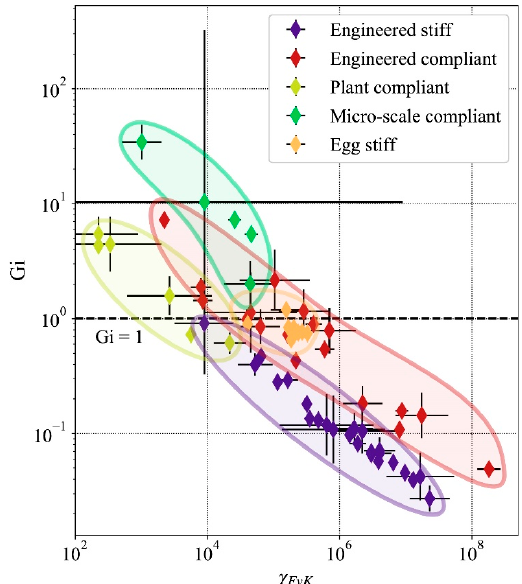
Figure 5. Classification of compliant and stiff thin shells. The nondimensional gravitational force density Gi is plotted as a function of the Föppl–von Kármán number γ FvK . The dotted line indicates values Gi = 1 for which the gravitational force becomes predominant in the equilibrium of the shell.